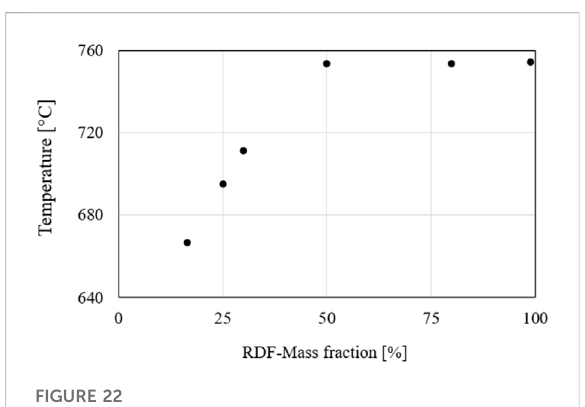
FIGURE 22 Comparison of temperatures at 8.45 m concerning RDF fuel mass